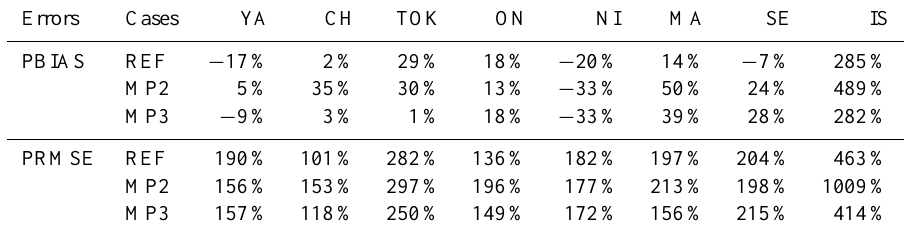
Table 3. The PBIAS and PRMSE of precipitation with different microphysics schemes. “YA”, “CH”, “TOK”, “ON”, “NI”, “MA”, “SE” and “IS” represent the stations “YAMAGATA”, “CHIBA”, “TOKYO”, “ONAHAMA”, “NIIGATA”, “MAEBASHI”, “SENDAI” and “ISHINO- MAKI”, respectively.